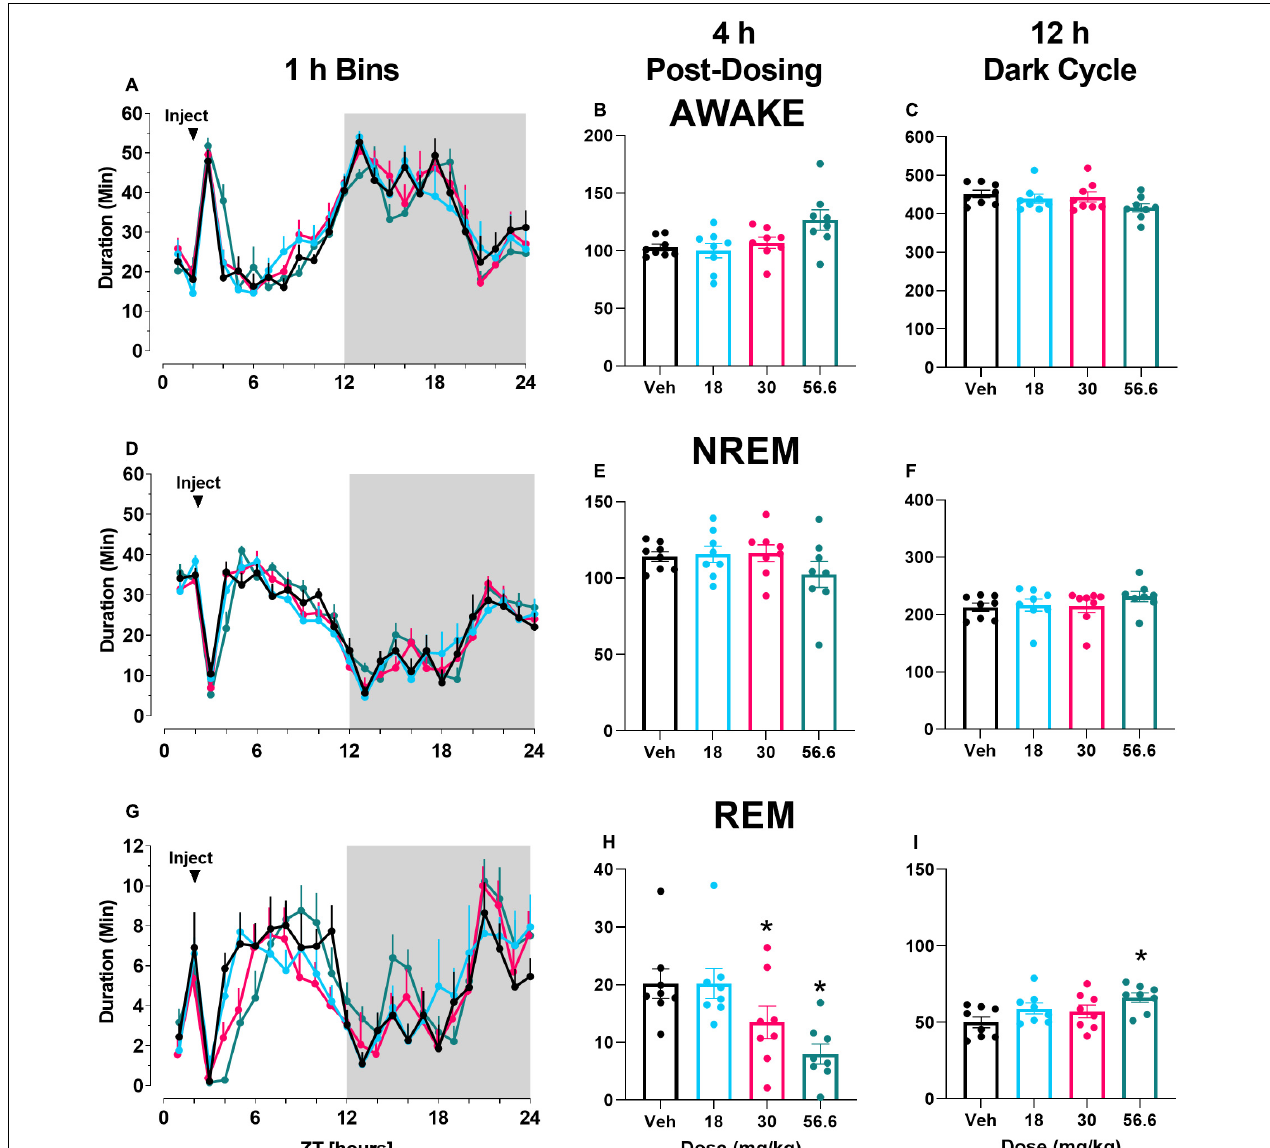
FIGURE 1 | M-5MPEP dose-dependently reduced duration of time in REM sleep. Time spent in wake (A–C) , NREM (D–F) , and REM (G–I) sleep in 1 h bins (A,D,G) over a 24 h time period, summed duration over the first 4 h after M-5MPEP administration (B,E,H) or the summed duration over the 12 h dark period (C,F,I) . M-5MPEP was administered 2 h into the light period, noted by arrow. * p < 0.05 compared to respective time in the vehicle-treated condition. Line and bar graphs represent mean ± SEM ( n = 8); individual circles on bar graphs depict individual data points. Gray rectangle around ZT 12–24 represents dark